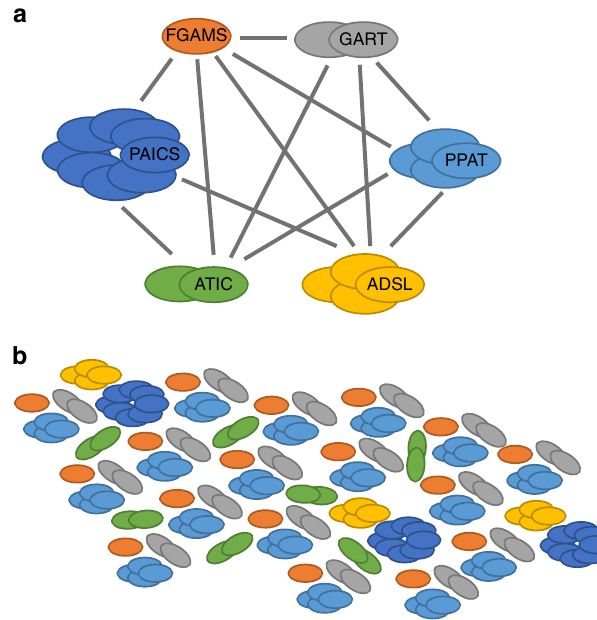
Fig. 3 The purinosome — a naturally occurring enzyme cluster? a Protein – protein interactions within the purinosome. Each holoenzyme of the purine biosynthesis pathway is shown, with the number of subunits re fl ecting the dominant oligomeric state of each. The grey lines indicate experimentally demonstrated pairwise protein – protein interactions. PPAT phosphoribosylpyrophosphate amidotransferase, ADSL adenylosuccinate lyase, ATIC 5-aminoimidazole-4-carboxamide ribonucleotide formyltransferase/5 ′ -inosinemonophosphate cyclohydrolase, FGAMS phosphoribosyl formylglycinamidine synthase, GART phosphoribosylglycinamide synthetase/phosphoribosylglycinamide formyltransferase/phosphoribosylaminoimidazole synthetase, PAICS phosphoribosyl aminoimidazole succinocarboxamide synthetase. b Potential organisation of the purine biosynthesis enzymes within the purinosome enzyme cluster. The fi rst three enzymes of the pathway, PPAT, GART and FGAMS, form a core complex that interacts with an ADSL – PAICS pair and with ATIC. In this way, multiple copies of the core complex are assembled via interactions with ADSL – PAICS and